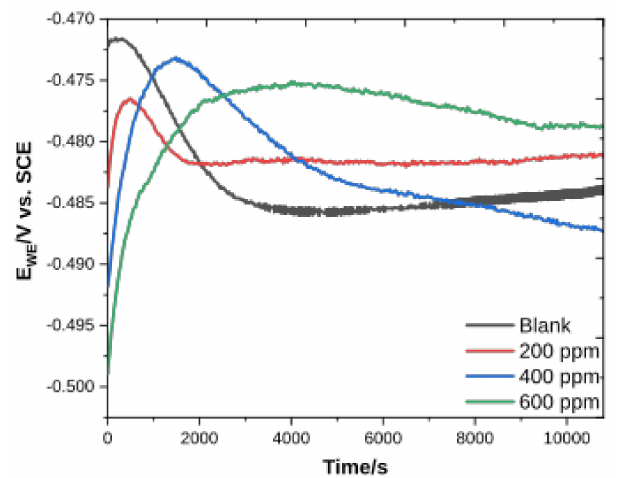
Figure 7. Open circuit potential (OCP) of mild steel immersed in 1 M HCl at di ff erent concentration for 3 h.